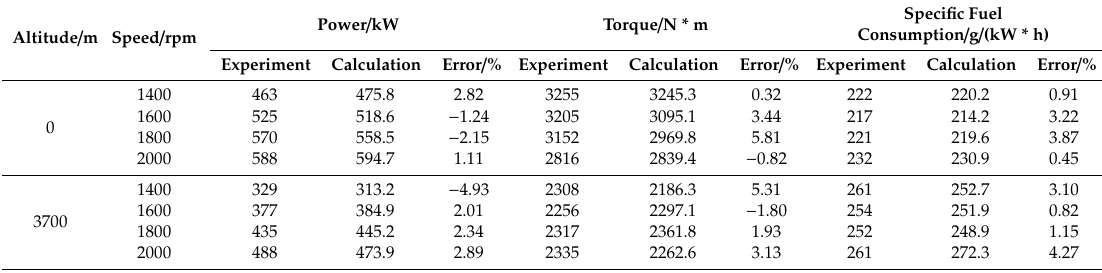
Table 3. The comparison of calculated values with experimental